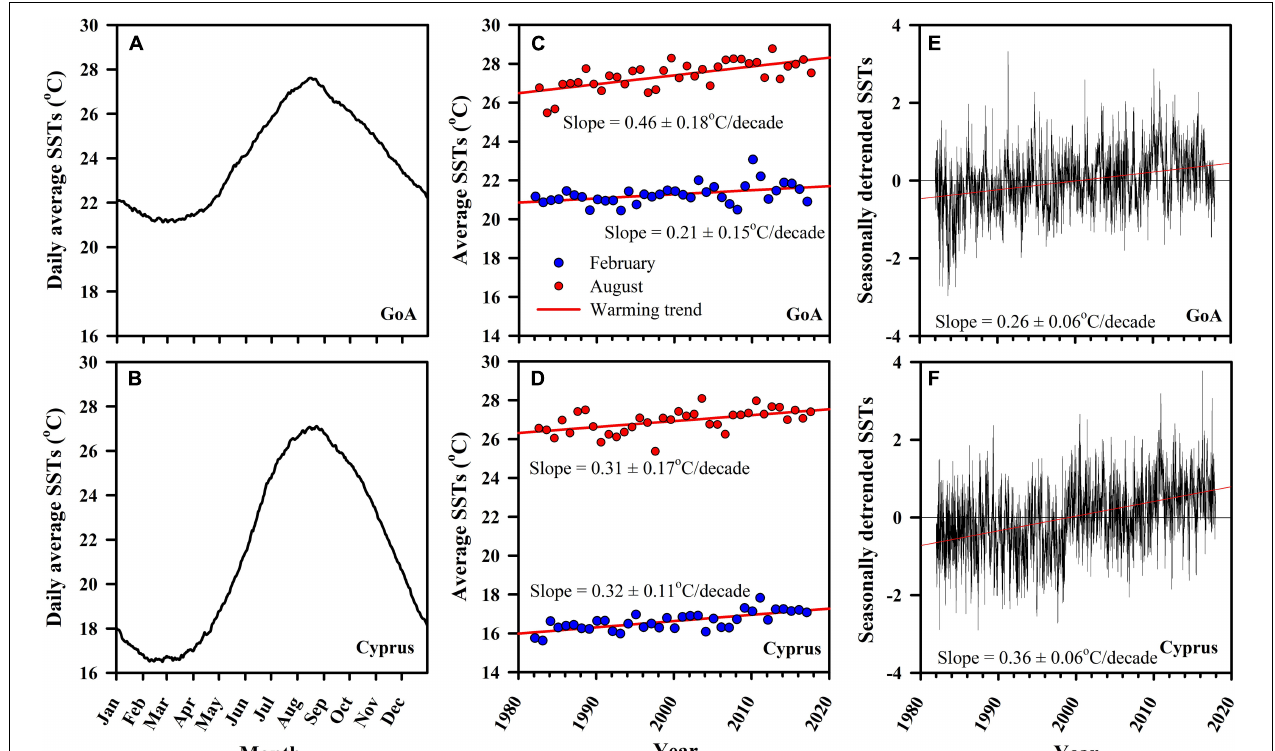
FIGURE 3 | Long-term monitoring of sea surface temperatures (SSTs) for both the native (GoA: A,C,E ) and invasive (Cyprus: B,D,F ) H. stipulacea collection sites for the period between 1982 and 2017 from NOAA dOISST.v2 dataset (www.ngdc.noaa.gov; Smith, 2016). Shown are (A,B) daily averages (Jan–Dec) of SSTs, (C,D) computed warming rates ( ◦ /decade) for February (winter; blue circles) and August (summer; red circles) with associated slopes of the linear regression, alongside the (E,F) seasonally detrended SSTs versus time with their associated slopes of the linear regression for the warming rates ( ◦ /decade).